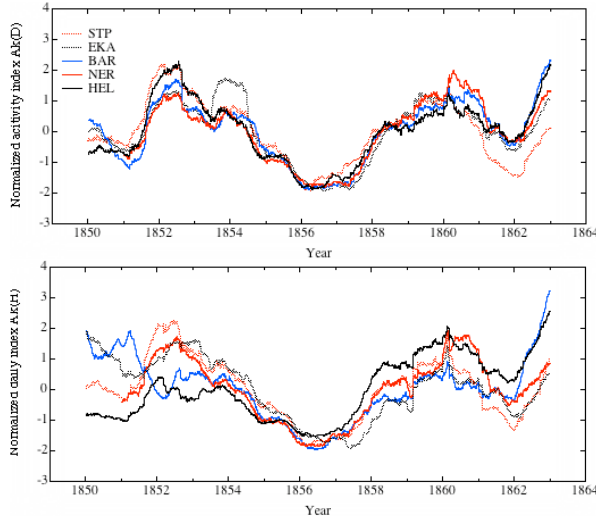
Fig. 7. Upper panel: 365d running means of normalized daily activ- ity indices (Ak) as calculated from the D-component. There are data from four Russian observatories together with the Helsinki data (see Table 1). Lower panel: Same as above but for the